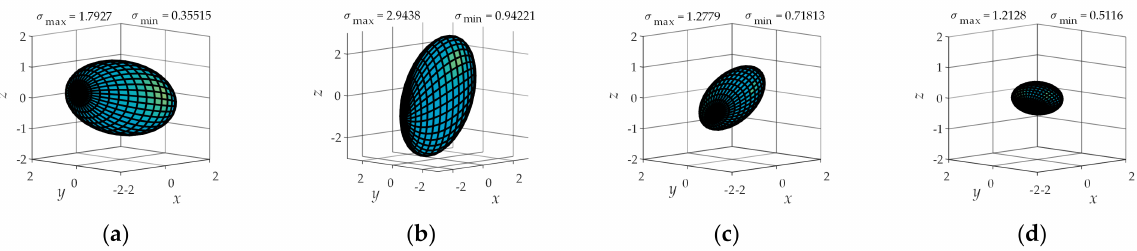
Figure 17. Manipulability ellipsoid of 5 R a 1 P in the 30 ◦ coronal plane. ( a ) β = 30 ◦ ; ( b ) β = 60 ◦ ; ( c ) β = 90 ◦ ; ( d ) β = 120 ◦